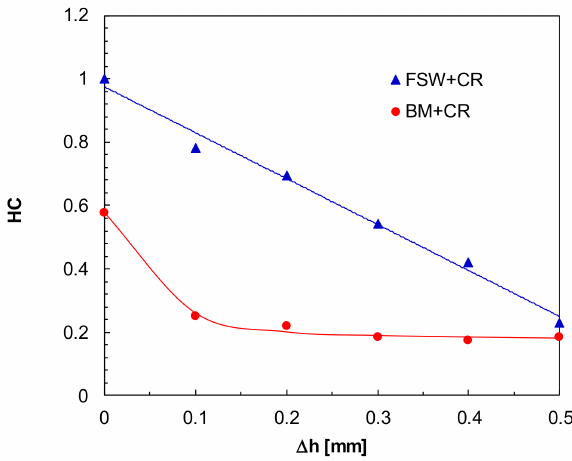
Figure 11. Hardening capacity vs. height reduction in both FSWed+CRed and BM+CRed